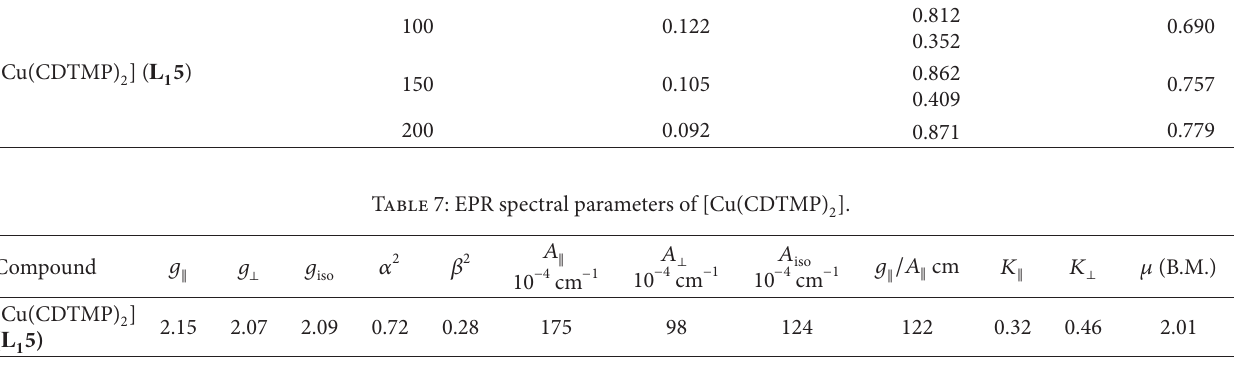
T 6: Redox potential of [Cu(CDTMP)